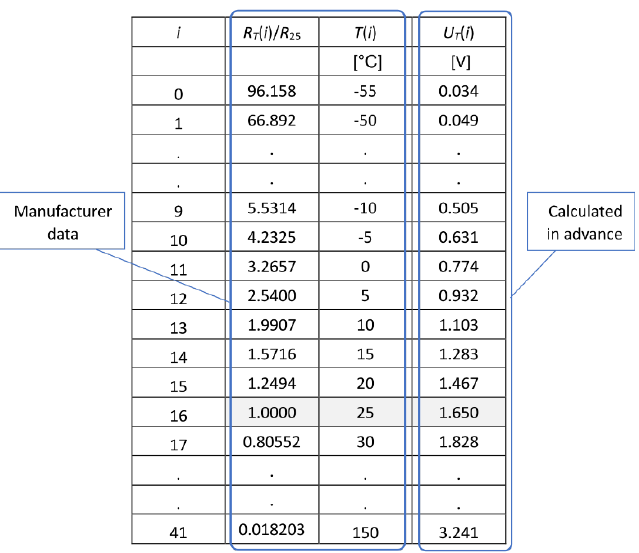
( b ) Figure 4. Influence of resistance R S value: ( a ) Voltage vs. temperature; ( b ) Voltage measurement sensitivity vs. temperature.